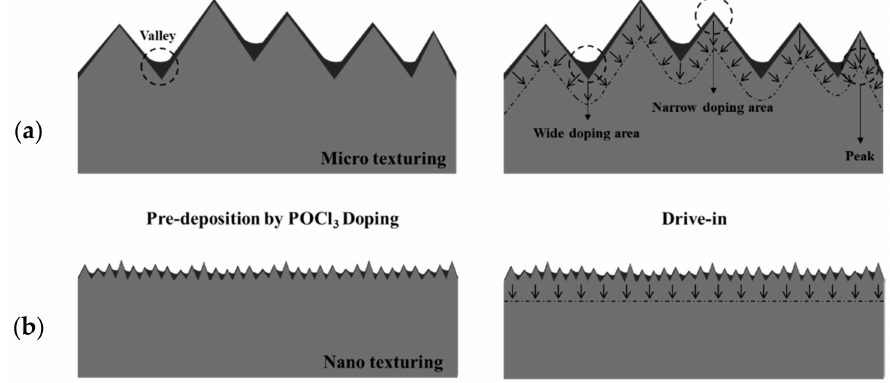
Figure 18. Schematic diagram of the emitter formation process according to pyramid size: ( a ) Micro- sized pyramid, ( b ) Nano-sized